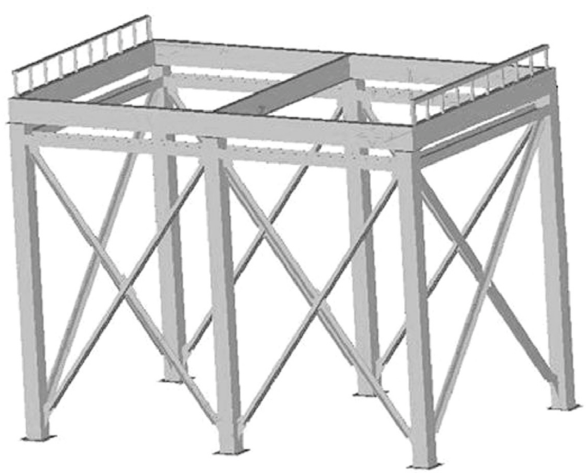
Figure 9: The assembly model of the bottom beam and